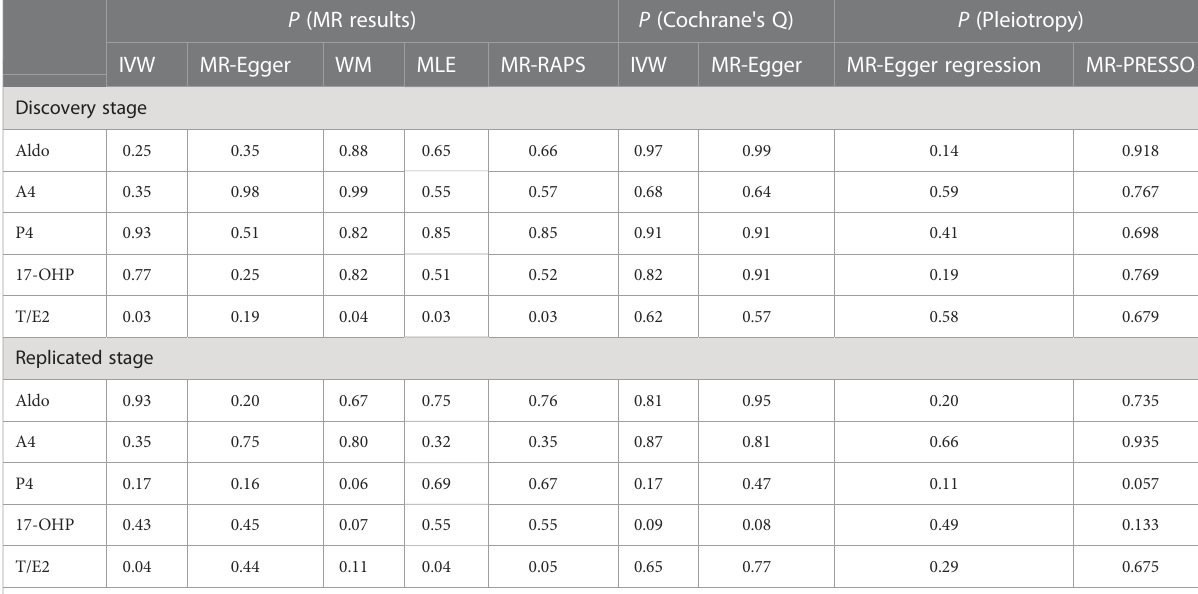
TABLE 2 MR results and sensitivity analyses between steroid hormones and glaucoma. P (MR results) P (Cochrane's Q) P